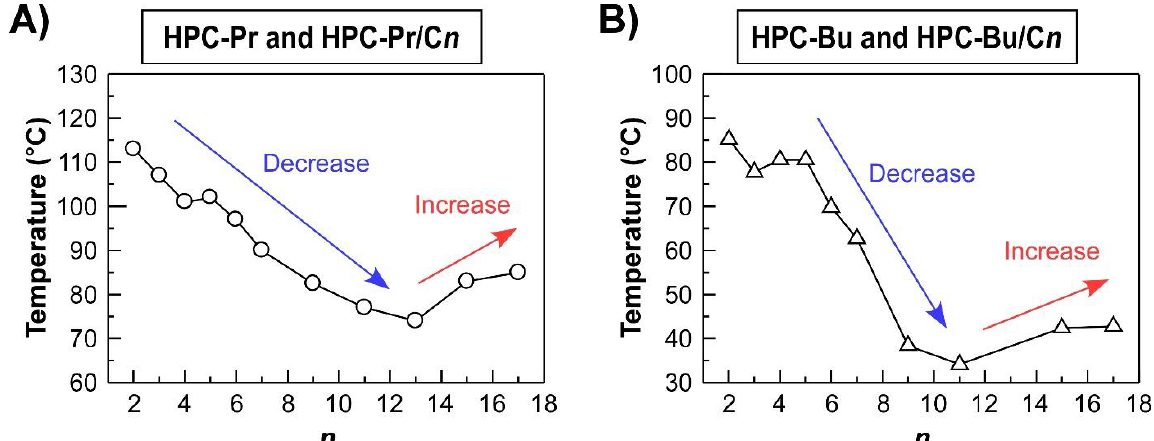
Figure 3. Effect of the side chain length ( n ) of HPC derivatives with propionyl ( A ) or butyryl group ( B ) on the temperature at which light of a certain wavelength is reflected. ( A ) The temperatures at which HPC-Pr ( n = 2) and HPC-Pr/C n reflect a light at 500 nm. ( B ) The temperatures at which HPC-Bu ( n = 3) and HPC-Bu/C n reflect a light at 600 nm. A plot at n = 13 was omitted because HPC-Bu/C13 did not exhibit any reflection colors (Supplementary Materials, Figure S8).